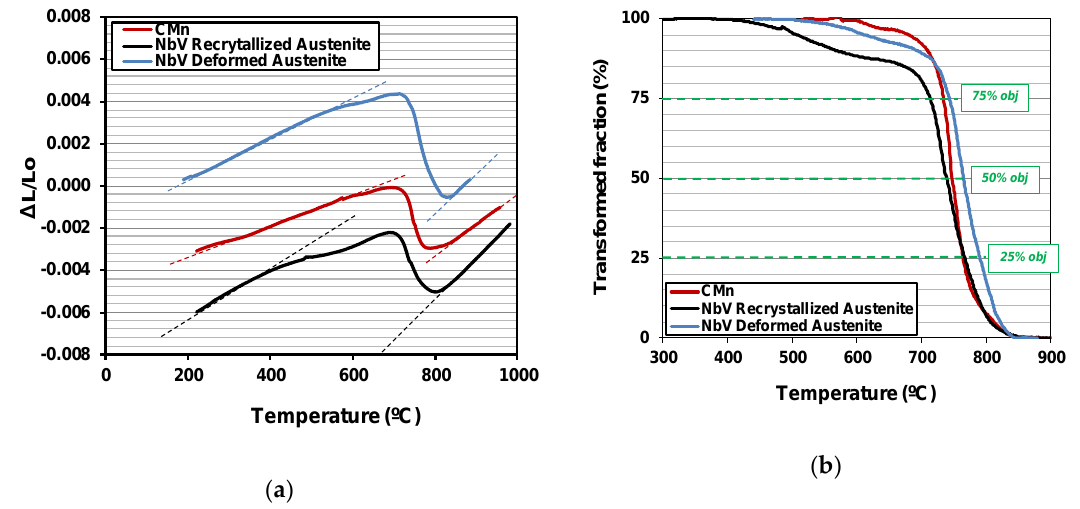
Figure 2. ( a ) Dilation curves and ( b ) evolution of transformed fraction in both steels and both austenite conditions for the NbV steel.